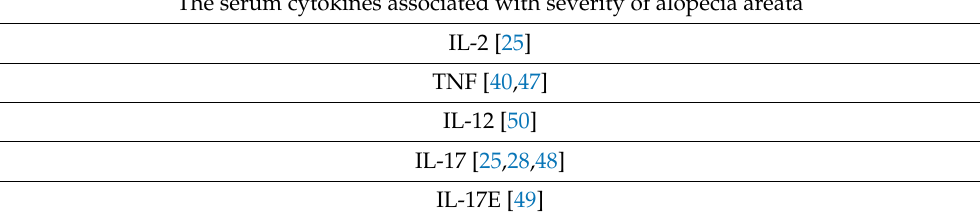
Table 4. The serum cytokines associated with severity of alopecia areata. The serum cytokines associated with severity of alopecia